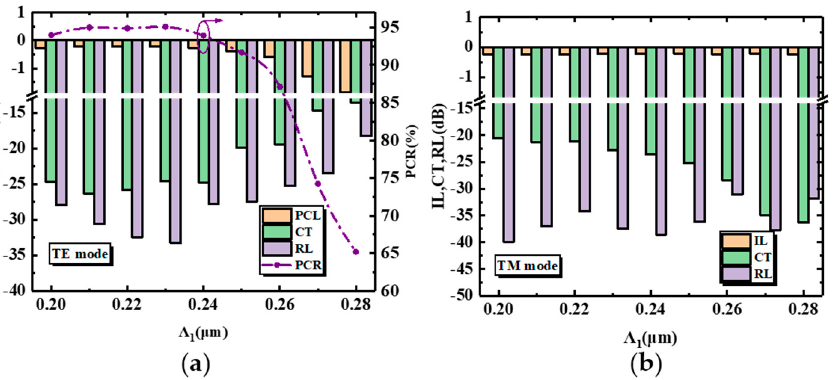
Figure 4. ( a ) PCL, CT, RL, and PCR of the proposed PSR versus Λ 1 for the TE mode. ( b ) IL, CT, and RL of the proposed PSR versus Λ 1 for the TM mode.